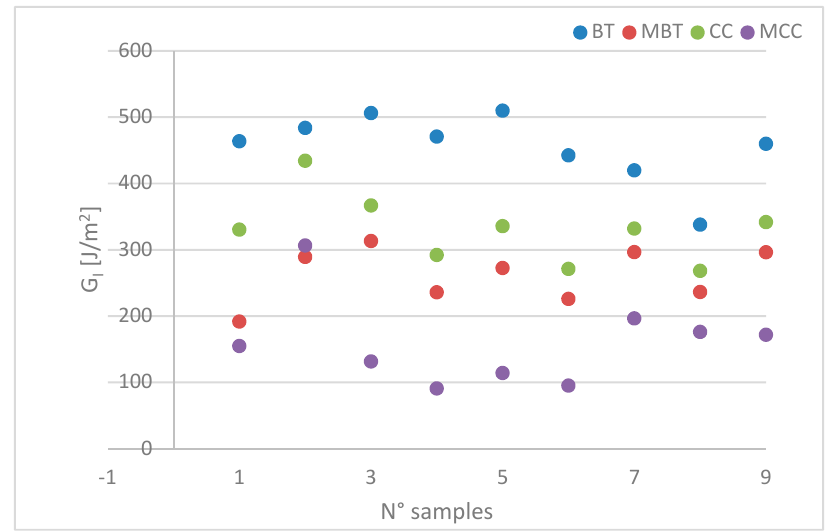
Figure 13. Comparison of the calculation methods for mode I delamination tests. BT—beam theory; MBT—modified BT; CC—compliance calibration; MCC—modified CC.